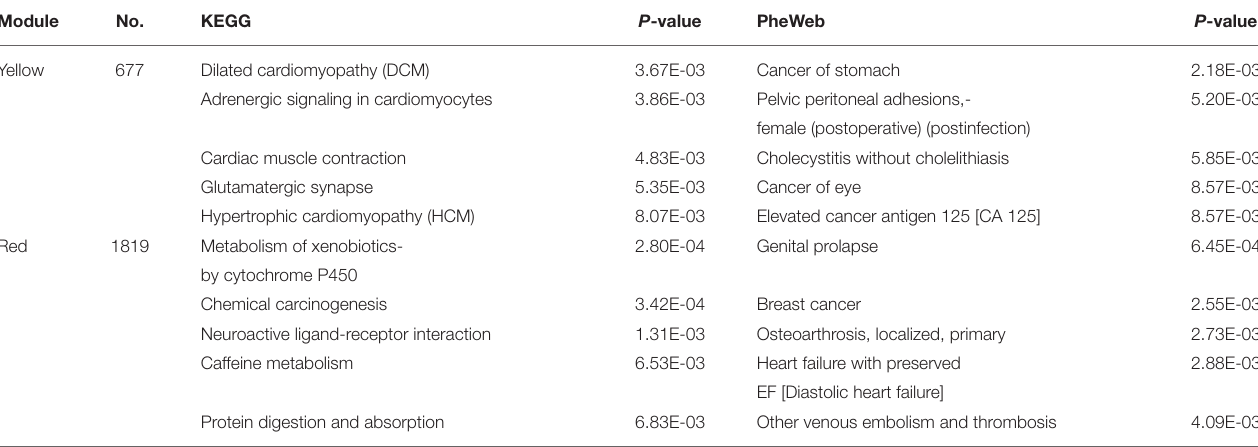
TABLE 2 | KEGG and PheWAS enrichment analysis by Enrichr of the important modules identified by WGCNA. Module No. KEGG P -value PheWeb Yellow